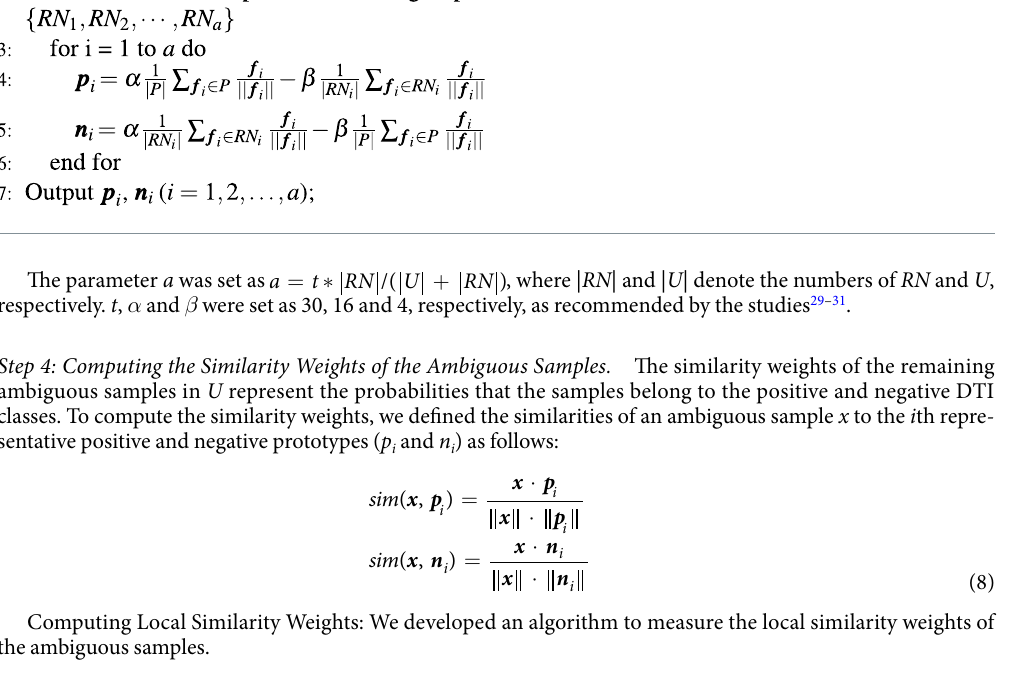
Algorithm 3. Computing the Local similarity weights of the ambiguous